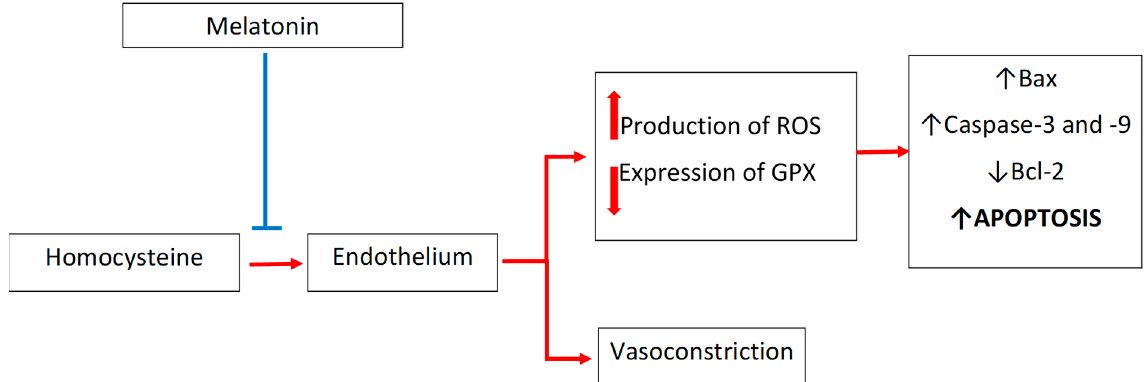
Figure 3. Melatonin prevents the vasculotoxicity of homocysteine. In endothelial cells, homocysteine enhances the synthesis of reactive oxygen species, which react intensively with glutathione, leading to a reduction in the level of this endogenous antioxidant. Simultaneously, a reduction of glutathione peroxidase expression does not allow for an effective reduction of lipid hydroperoxides and hydrogen peroxide. As a result of increased oxidative stress, the motility of the blood vessel wall is disturbed, vasoconstriction is increased, and the ability to relax is impaired. Reactive oxygen species initiate endothelial cell apoptosis. Melatonin prevents homocysteine-dependent pathological changes by directly scavenging reactive oxygen species and by stimulating glutathione peroxidase expression. Bax, bcl-2-like protein 4; Bcl-2, B-cell lymphoma 2; GPX, glutathione peroxidase; ROS, reactive oxygen species.